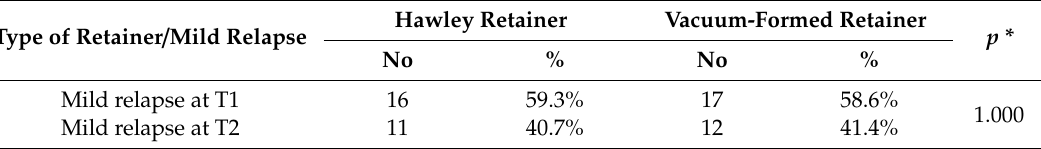
Table 8. Distribution of the patients according to the type of mild relapse and type of retainer.